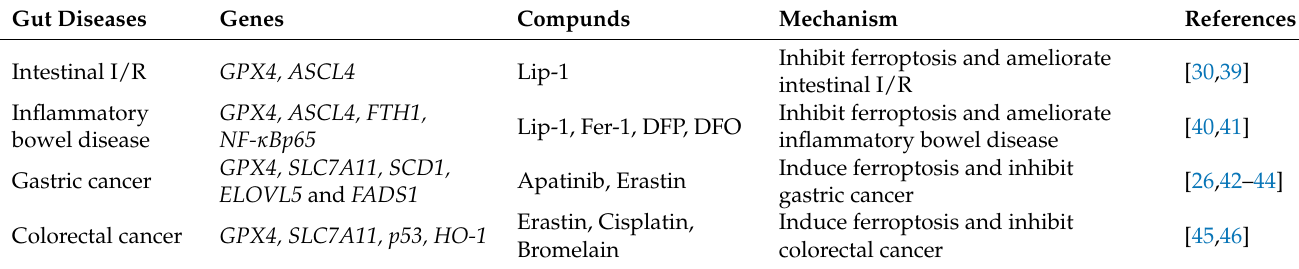
Figure 2. The role of ferroptosis in gastrointestinal disease. Footnote: Ferroptosis is a double-edged sword in gastrointestinal disease, which is mainly regulated by GSH homeostasis, plasma PUFA concentration, and liable iron pool. On one hand, ferroptosis activationhas a negative impact on intestinal I/R injury and inflammatory bowel disease (IBD). On the other hand, ferroptosis activation could trigger cell death and alleviate gastric cancer (GC) and colorectal cancer (CGC). Red arrows indicate ferroptosis activation induce the corresponding diseases. Blue arrows indicate ferroptosis activation alleviate the corresponding diseases. Table 1. Crucial molecular players and potential therapeutic targets involved in regulation of gastrointestinal